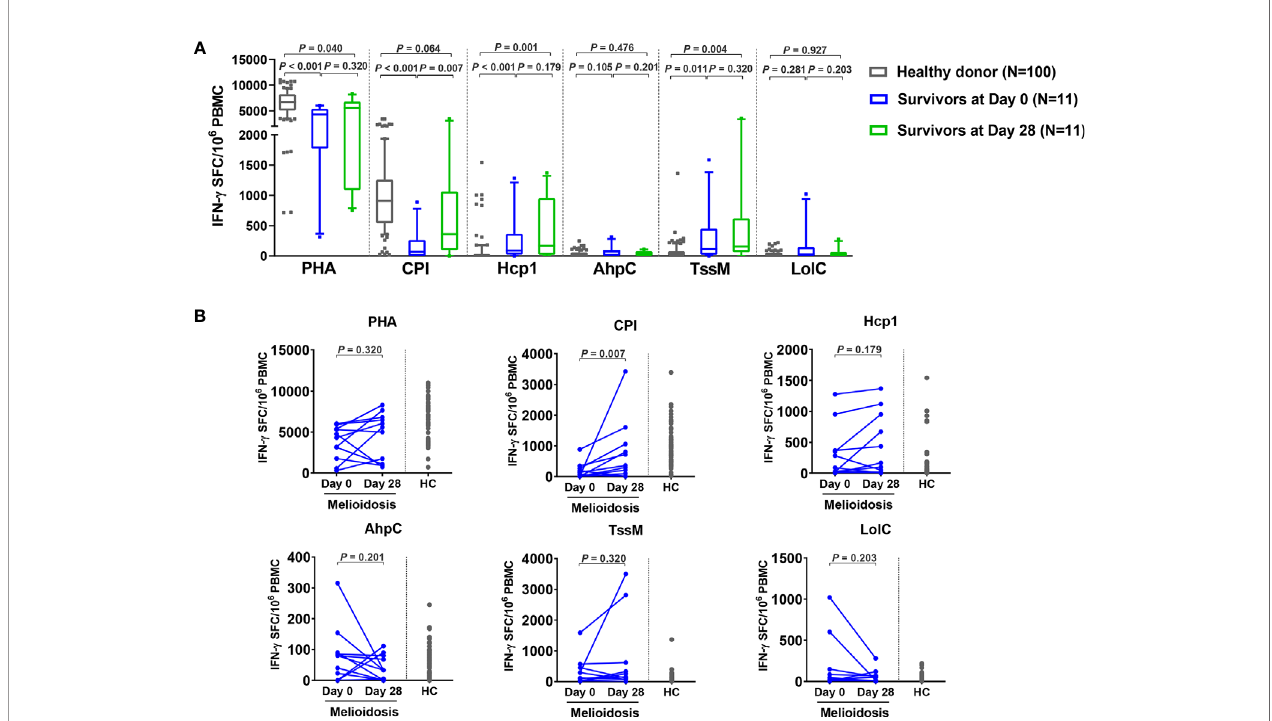
FIGURE 4 | Cellular immune responses to B pseudomallei vaccine candidate antigens in survivors at day 28 versus day 0. (A) Antigen-speci fi c IFN- g secreting cells were analyzed in 11 survivors at day 0 and day 28 and in 100 healthy donors. Box plots represent 25 th and 75 th percentile boundaries in the box with the median line within the box; the whiskers indicate the 10 th and 90 th percentiles. Statistical signi fi cance between healthy donor and melioidosis patients was determined using the Mann-Whitney test and signi fi cant differences between time points within a group were determined using paired Wilcoxon test. (B) Antigen-speci fi c IFN- g secreting cells of melioidosis survivors at day 0 and day 28. Data from healthy donors (HC) were plotted as